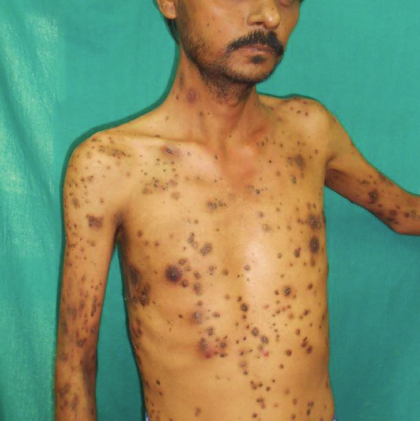
Figure 1: Crusted lesions on erythematous base over the trunk.